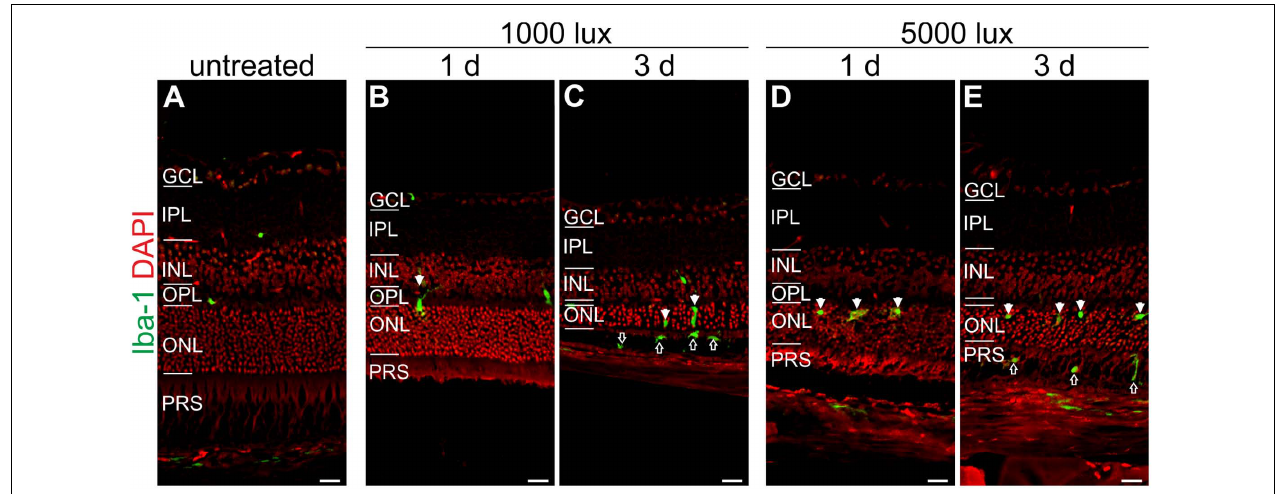
FIGURE 7 | Microglia/macrophage cells migrate at 1 day after LD in the ONL and at 3 days in the PRS. Immunoreactivity for Iba-1 (green) showed microglia/macrophage distribution in (A) an untreated mouse retina, (B,C) retinae treated with 1000 lux for 24 h and (D,E) retinae illuminated with 5000 lux for 0.5 h. (B,D) Mice showed microglia/macrophage migration into the ONL at 1 day post-LD (white arrows). (C,E) Three days post-light treatment microglia/macrophages were located in the ONL (white arrows) and additionally in the PRS (black arrows) in both light treatment regimens. Retinal layers from the top to the bottom: GCL, ganglion cell layer; IPL, inner plexiform layer; INL, inner nuclear layer; OPL, outer plexiform layer; ONL, outer nuclear layer; PRS, photoreceptor segments; RPE, retinal pigment epithelium; Ch, choroid. Scale bars, 20 µ m.